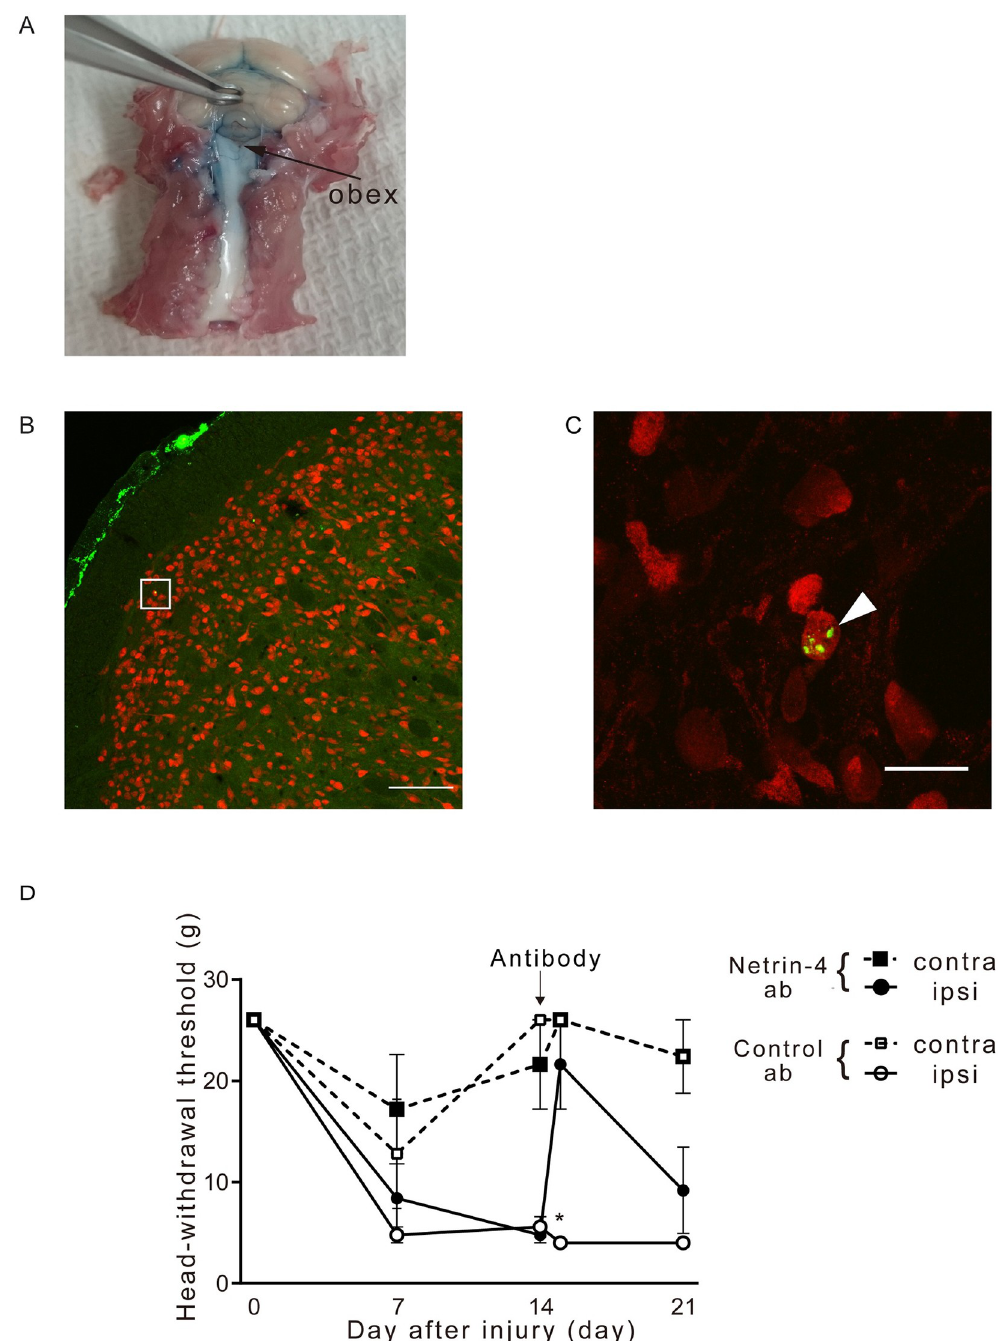
Fig 2. Effects of anti-Netrin-4 antibody administration on pain behavior in trigeminal neuropathic pain model rats. (A) Confirmation of administration area by Evans Blue. (B and C) Penetration of anti-Netrin-4 antibody (Antibody) into the Vc. Double immunofluorescence staining for the fluorescence dye-conjugated Netrin-4 antibody (DyLight 488; green) and NeuN (red). The fluorescence of antibody was observed on neurons (arrowhead) in Vc. (C) is high magnification image corresponding to the square area in (B). Bars: (B) 100 μ m, (C) 20 μ m. (D) Head-withdrawal threshold after administration control IgG or anti-Netrin-4 antibody to CCI-ION or Sham injury (n = 5). The data are presented as the mean ± SEM. � , P < 0.05; Tukey